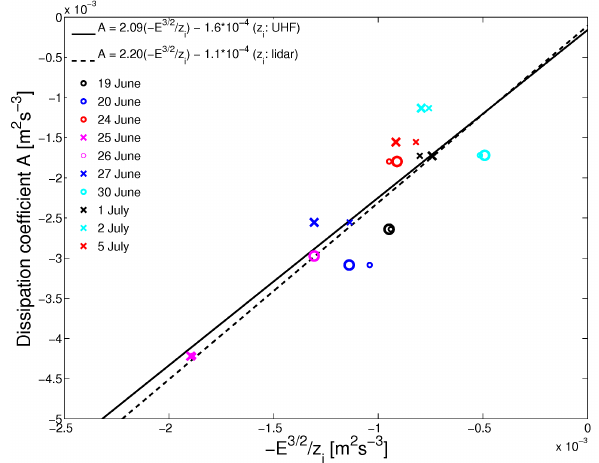
Figure 11. Dissipation coefficient A as a function of mean after- noon TKE and mean afternoon boundary layer height determined from lidar and UHF profiler. Two best-fit linear expressions (full and dashed line) have been included for using the UHF profiler and lidar z i estimates. Large and small symbols correspond to using li- dar and UHF profiler data,